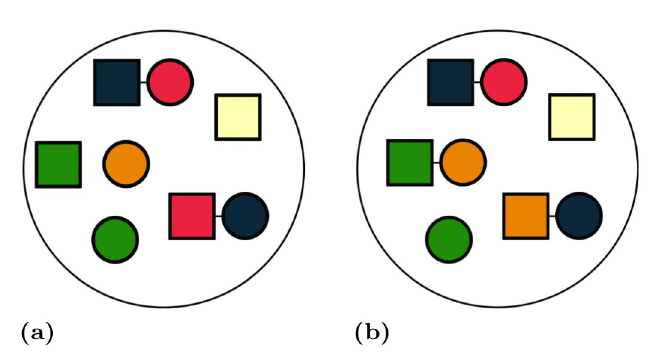
Fig 4. Examples of solutions. (A) An example of graphical representation of a solution. (B) Updated solution after the rules from Fig 5 were applied. The first rule Fig 5A was applied on the green square and the orange circle and produced complex square-circle complex. Note there are more options how the agents could be matched by the rule—each combination of free square and circle. The second rule Fig 5B was applied on the complex of red square and blue circle where the colour of square was changed from red to orange. The third rule Fig 5C could not be applied because there is no such complex with a green